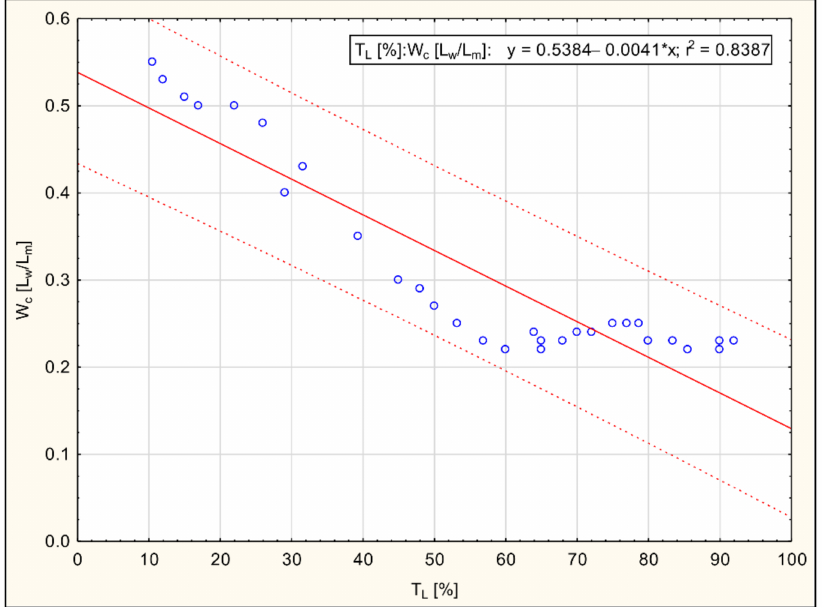
Figure 6. Changes in water consumption (W c ) in the cow milking process with an increase in the technological index level (T L ).